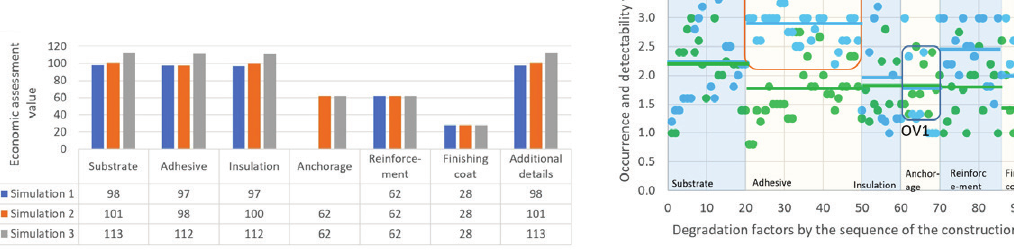
Figure 5. The average economic assessment value by layers